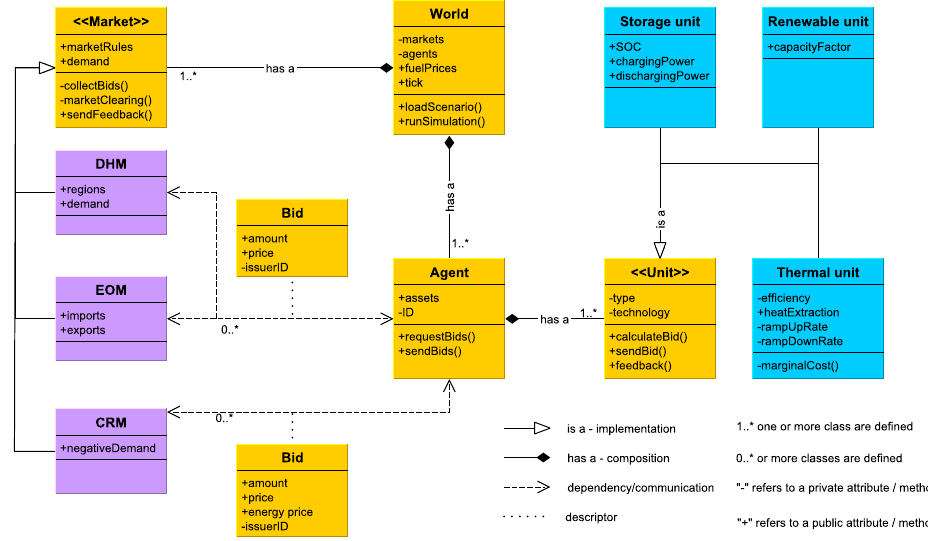
Figure 1. UML class diagram of the flexABLE